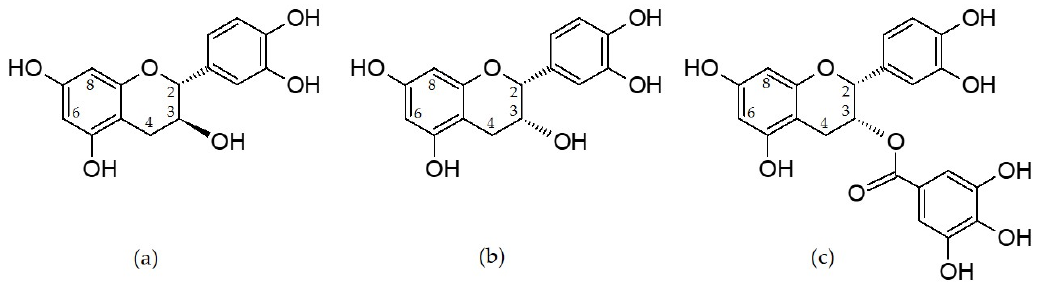
Figure 1. Molecular structures of (+)-catechin ( a ), ( − )-epicatechin ( b ) and ( − )-epicatechin gallate ( c ).